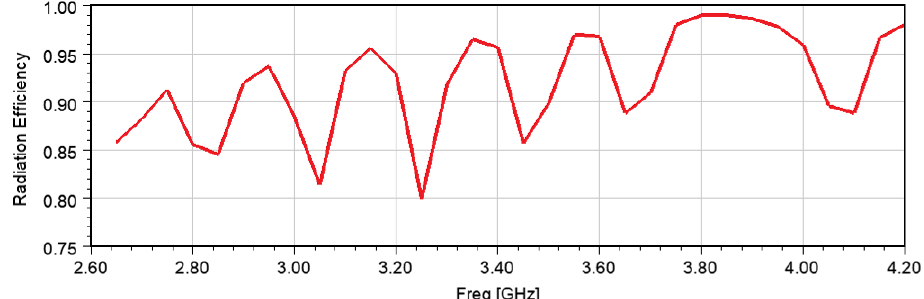
Figure 6. Radiation efficiency of the proposed antenna 1.